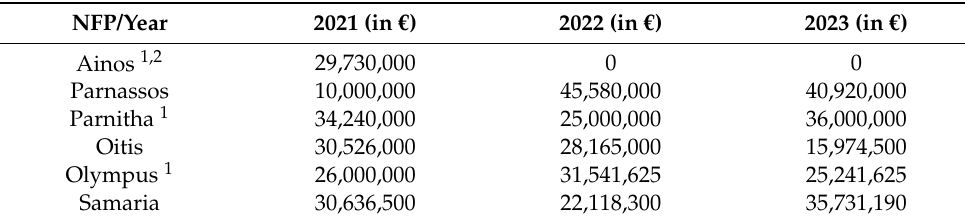
Table 1. Planning expenditure targets per year for each NFP being examined.